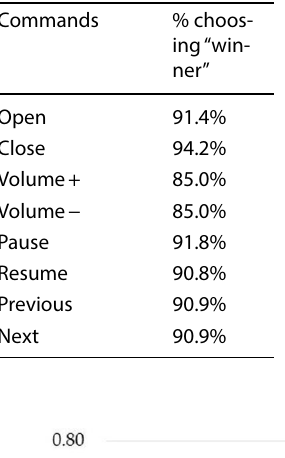
Fig. 6 Agreement rates for gesture proposals elicited with right-hand; NOTE: Referents are shown on the horizontal axis in descending order, error bars show 95% confidence